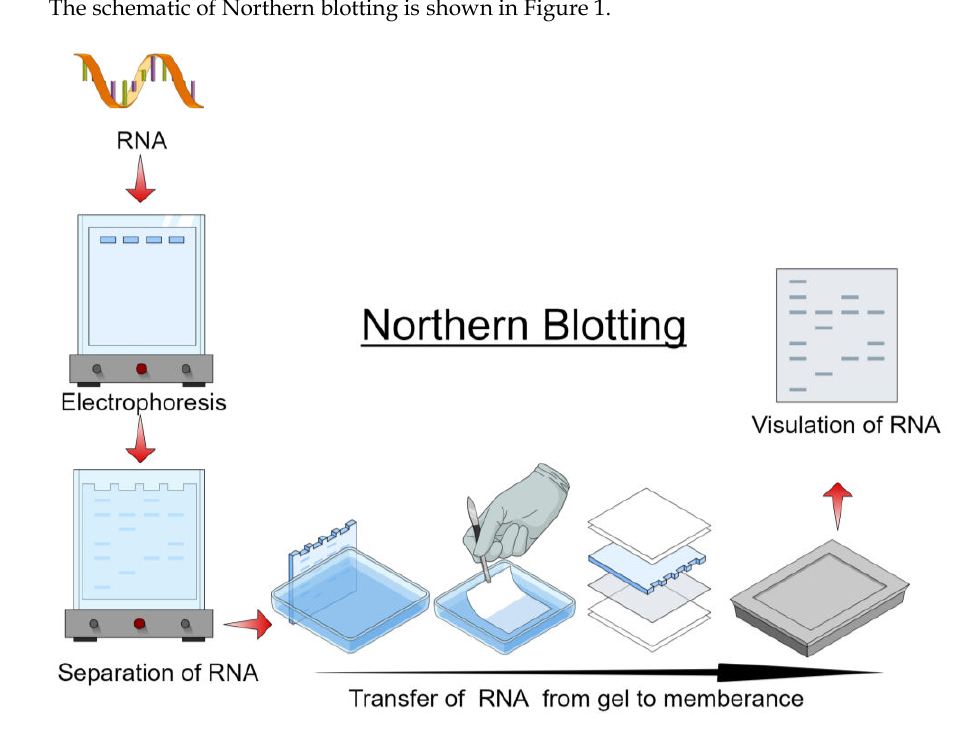
Figure 1: General schematic of Northern